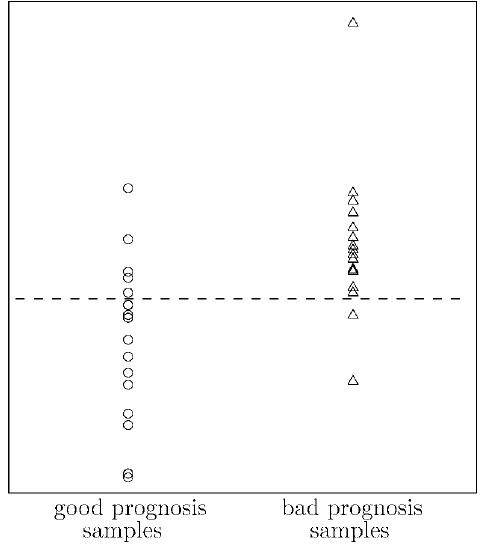
Fig. 8. The adaptive lacunarity feature L ( − ) ( p ) extracted from the 30% peripheral part of nuclei from histological sections are plotted for each sample of ovarian cancer. Each sample (patient) is repre- sented by the 10 percentile of the distribution of the feature value extracted from about 280 cell nuclei per sample. The dotted line rep- resents the decision boundary for the classifier computed from the whole data set.